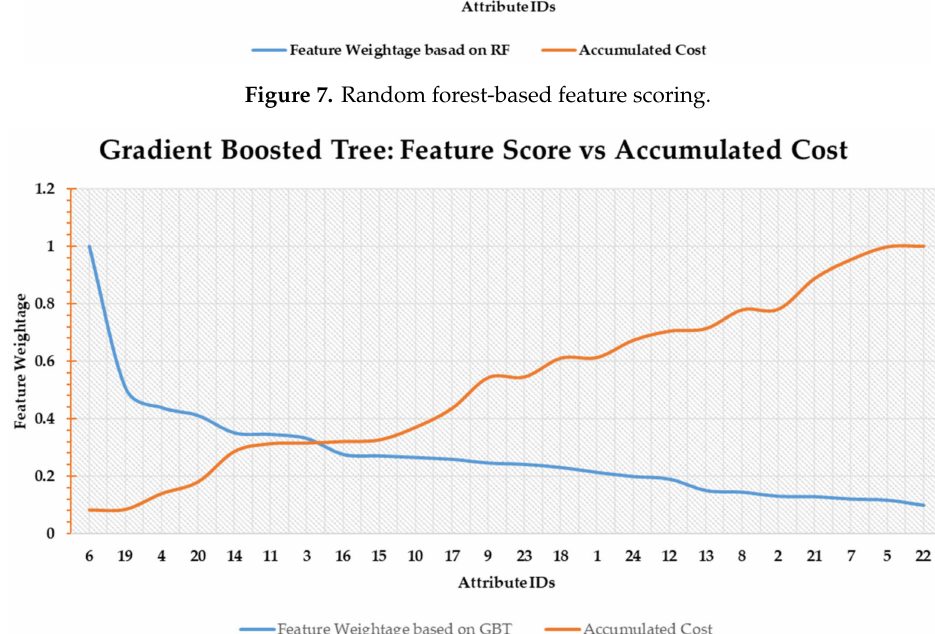
Figure 8. Gradient boosted trees based feature